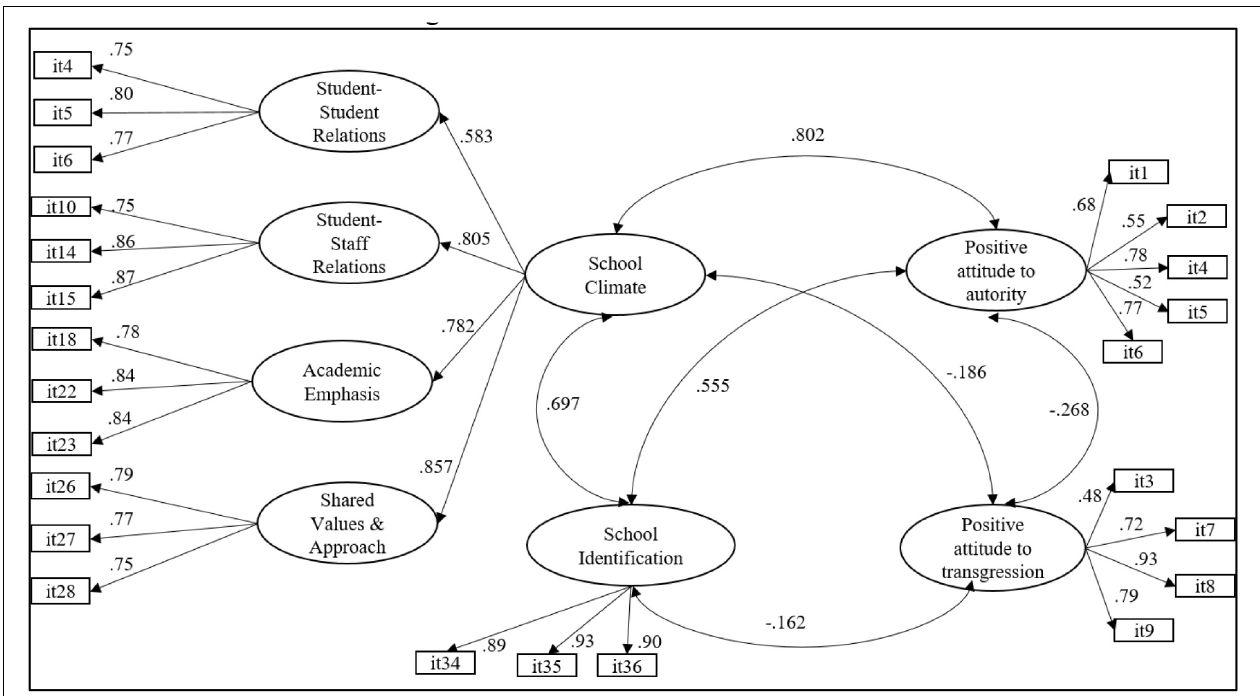
FIGURE 2 | Structural equation model. All the estimated parameters were statistically significant ( p <